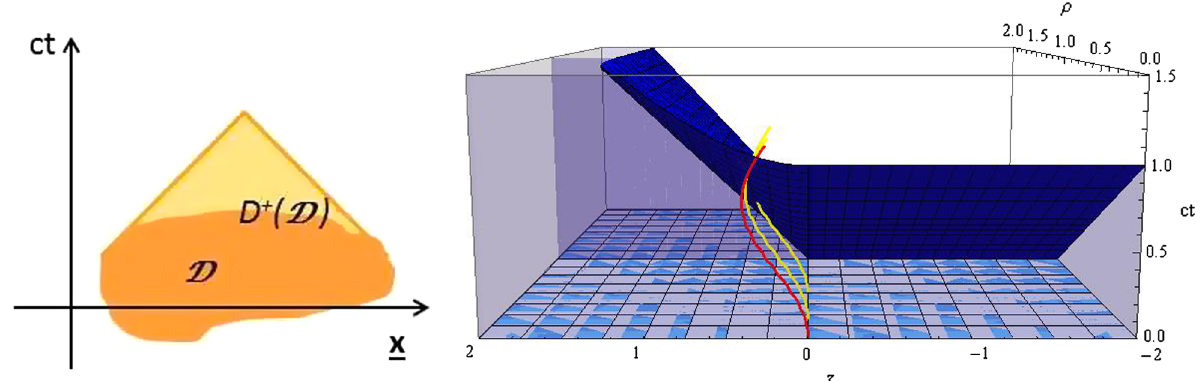
FIG. 11. Left: future Cauchy development D þ ð D Þ of a generic domain D . Right: D 0 1 (light blue) and D þ ð D 0 1 Þ (shaded region between the blue and light blue hypersurfaces) in ð ρ ; z; ct Þ coordinates (we have dropped the inessential angle φ ); worldlines of the X ¼ 0 electrons (red) and of a couple of off- ~z -axis electrons (yellow); the former remain in D þ ð D 0 1 Þ